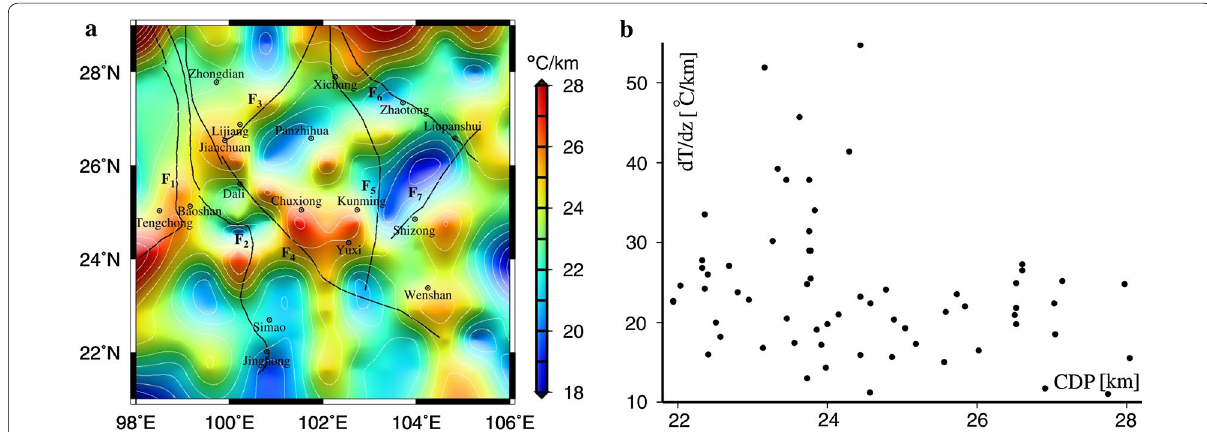
Fig. 6 a Geothermal gradient retrieved from the Curie surface, and b distributed scatter plot for the measured geothermal gradient and depth of the Curie